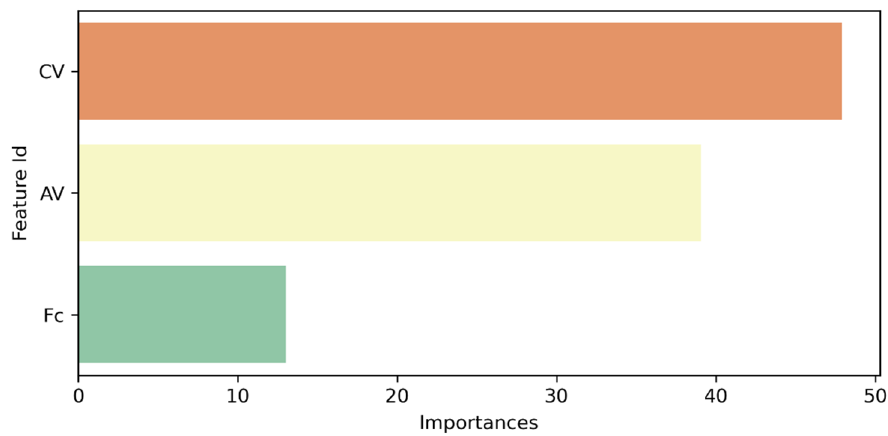
Figure 13. CatBoost model training process.